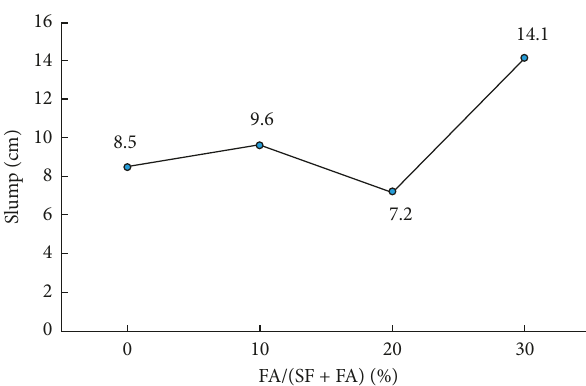
Figure 10: Influence of FA-replaced partial SF on fluidity of UHPFRC.